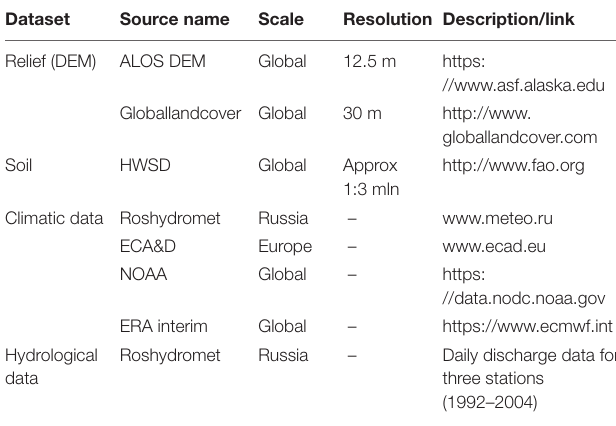
TABLE 3 | The datasets used to set up and operate the